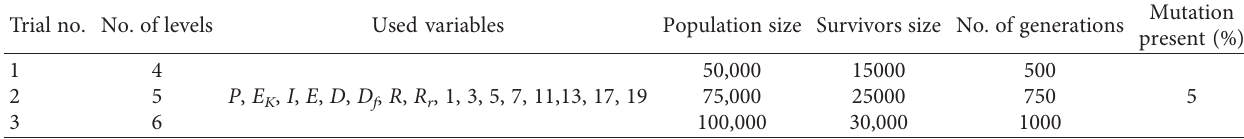
Table 4: Characteristics of each (GEP) trial.